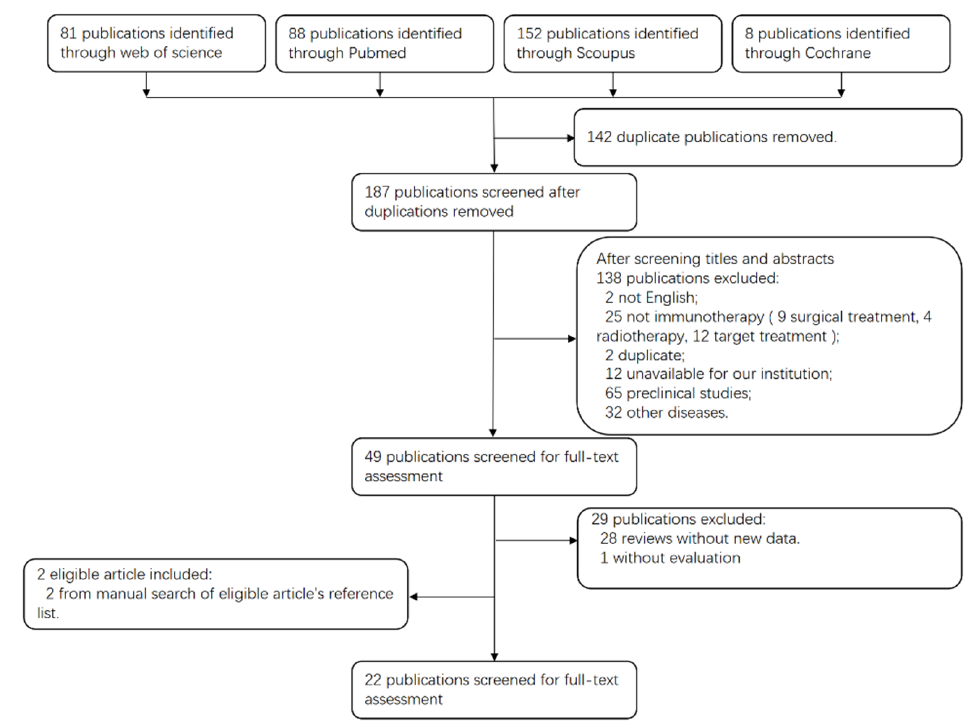
Figure 1. PRISMA flow diagram of the study selection process.